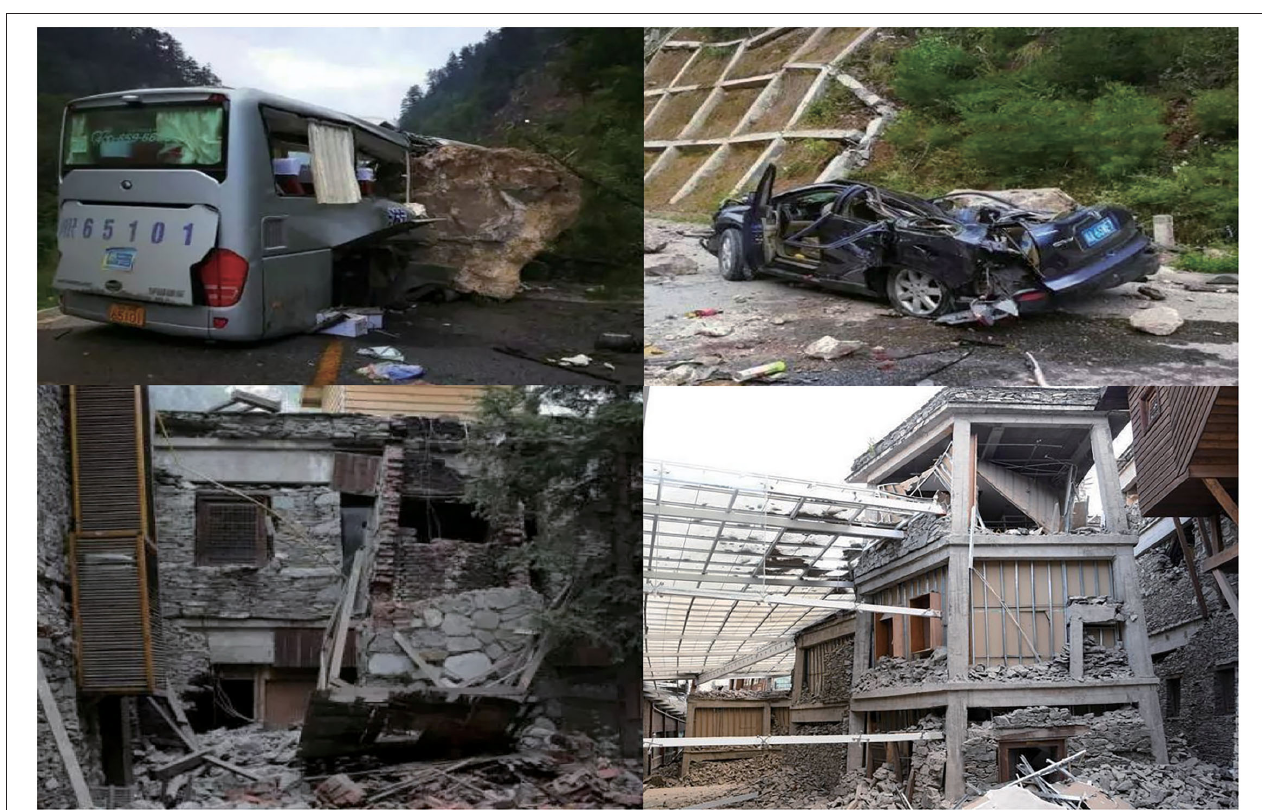
FIGURE 2 | Scenes in Jiuzhaigou after the